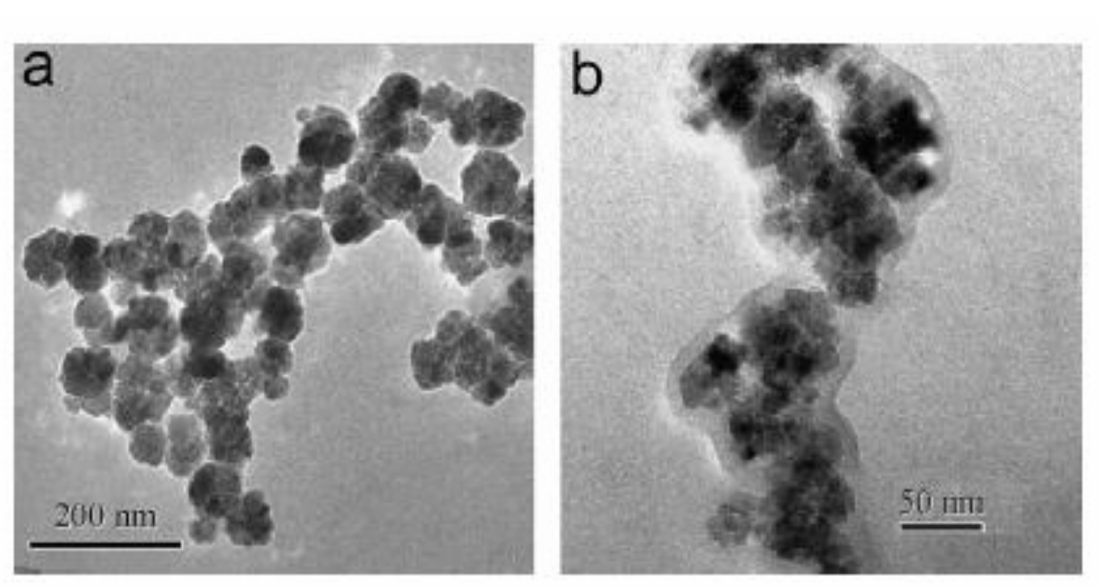
Figure 15. TEM images [137] of the clustered particles for two di ff erent samples. The mean diameter of the magnetic nanoparticles is 13 nm ( a ) and 17 nm ( b